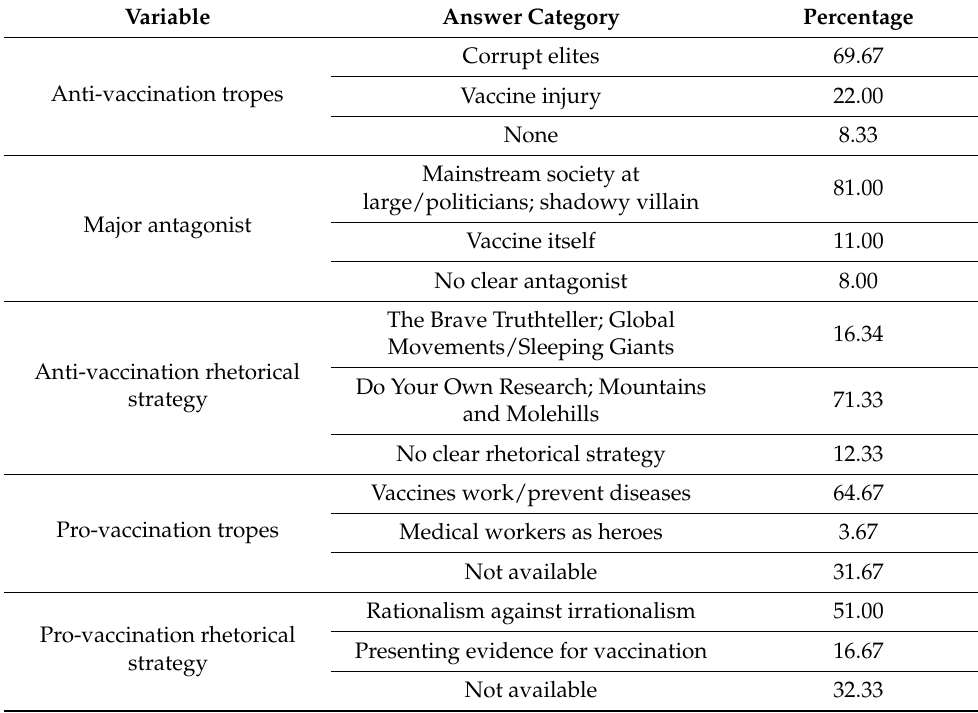
Table 2. Descriptive statistics for tropes, antagonists and rhetorical strategies.